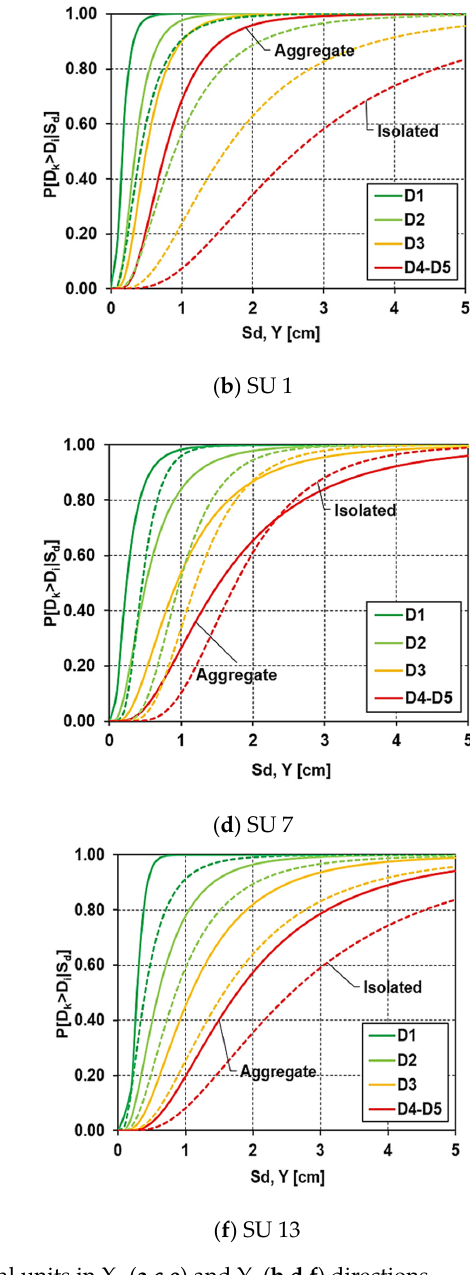
Figure 13. Fragility curves for the examined structural units in X- ( a , c , e ) and Y- ( b , d , f ) directions. From the obtained results, it was observed how the probability of exceeding a certain damage threshold DS i (with i = 1, …, 4) is much more accentuated in the case of the clus- tered configuration. As explained in Section 3.2, the increment in terms of mass deriving from close SUs provides an increase in the seismic load, but a consequent reduction of the expected displacements. Considering SU 1 in X-direction, for a maximum displacement of 0.5 cm, the achieved damage thresholds D1 and D2, evaluated for aggregate and iso- lated configurations, are comparable to each other. Instead, starting from a target displace- ment of 1 cm, there is a difference in terms of the expected damage probability thresholds. In particular, SU 1 considered as isolated provided a lower probability of damage than the same SU placed in the masonry compound. Extending this consideration to the Y- direction), the same condition arises. This circumstance depends on the fact that the ref- erence SU in the isolated condition shows an increase in the displacements (d y = 0.60 cm; d u = 1.46 cm) compared to those of the clustered SU (d y = 0.23 cm; d u = 1.44 cm) which has lower values of the expected damage thresholds. This condition was observed even for the other SUs analyzed. For an exhaustive comparison between aggregate and isolated SUs, in Table 4, the displacements (yielding and ultimate) achieved for the case study configurations are de- picted. Table 4. Target displacements, d y and d u , for the examined SUs. Structural Units Isolated (X dir.)